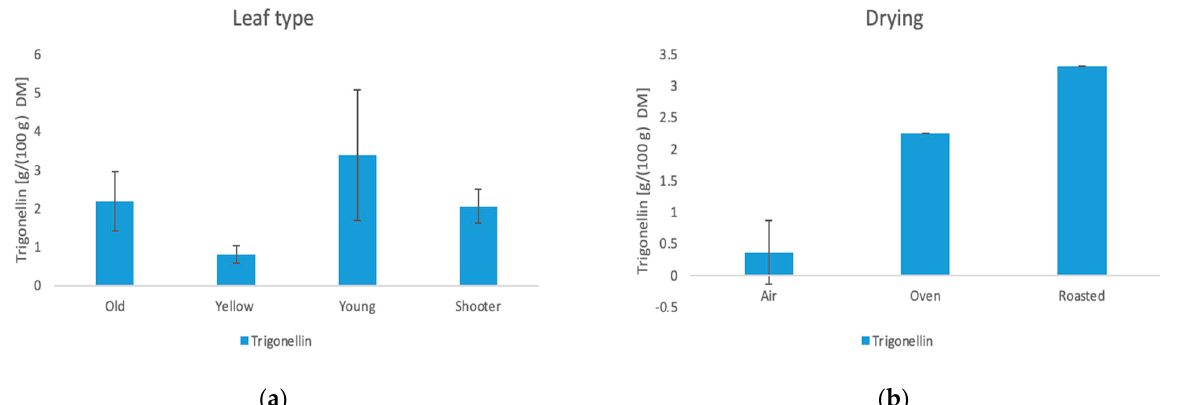
Figure 11. ( a ) Influence of the leaf type on the trigonelline content. ( b ) Influence of the drying method on the trigonelline content.